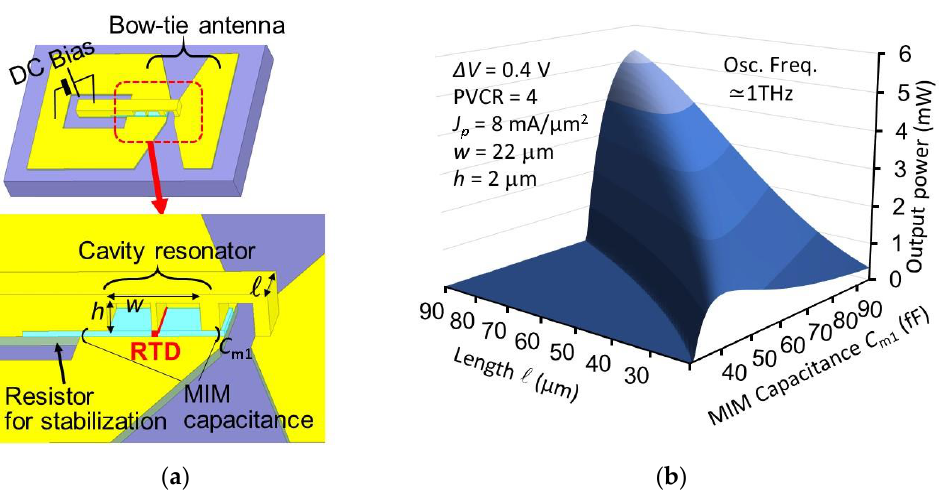
Figure 7. RTD oscillator integrated with rectangular cavity and bow-tie antenna for high output power [35, 83]: ( a ) Oscillator structure, and ( b ) calculation of output power as a function of cavity length and capacitance at the metal-insulator-metal (MIM) structure connecting bow-tie and cavity.